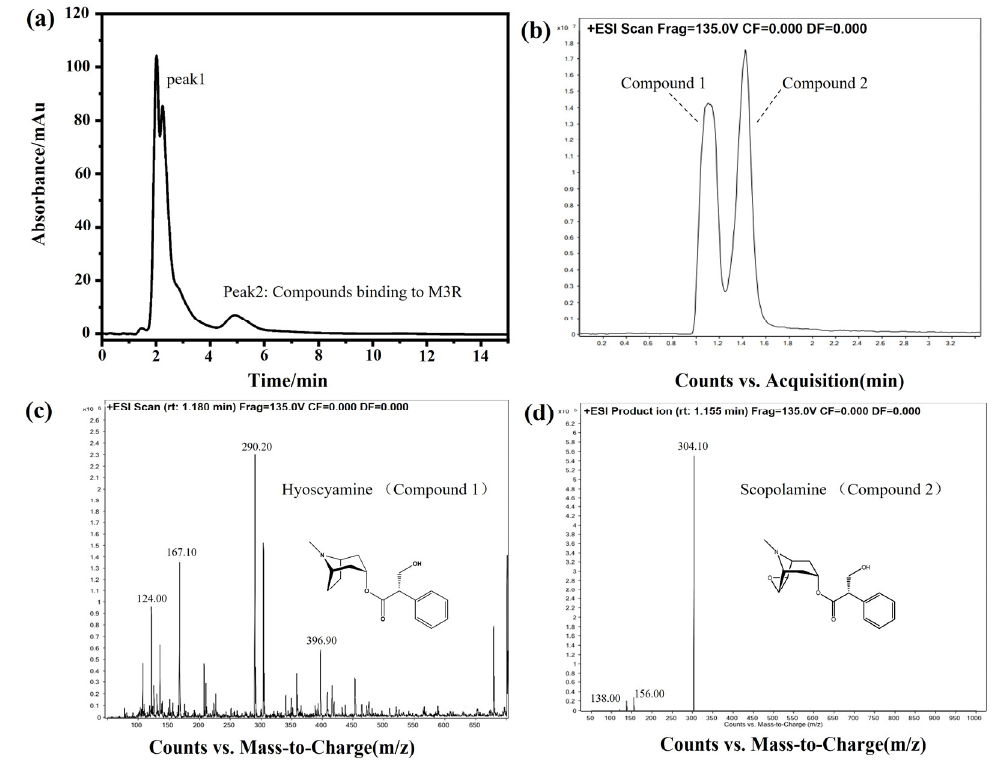
Figure 8. Identification of bioactive compounds of Daturae Flos extract using the M3R- immobilized column. ( a ) Representative chromatogram of the Daturae Flos extract on the M3R- immobilized column. Peak 2 was attributed to the compounds in the extract that specifically bind to M3R since the retention time was longer than the void time. ( b ) The total ion current of peak 2 in the chromatogram on the reversed-phase XDB-C 18 column (2.1 mm × 150 mm, 3.5 µm) coupled with an electrospray-MS/MS system. ( c ) Compound 1 was identi fi ed as hyoscyamine by HPLC-MS/MS. ( d ) Compound 2 was identi fi ed as scopolamine by HPLC-MS/MS.